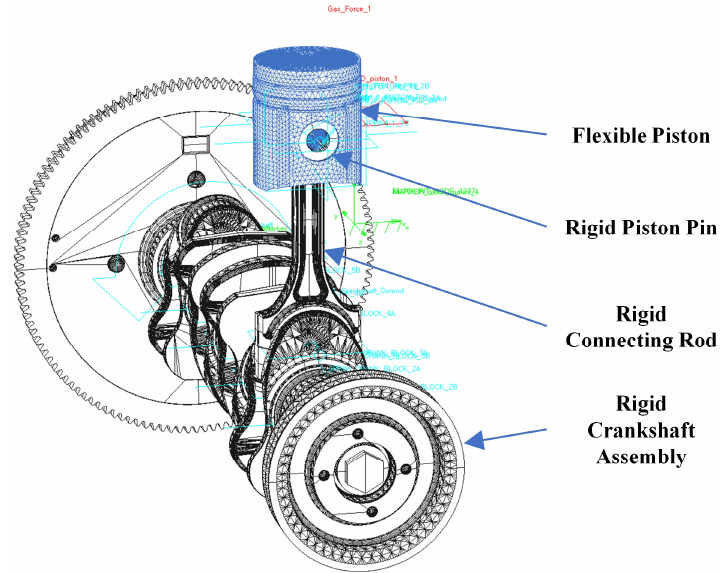
Figure 2. The MBD model of piston–liner interaction. Crankshaft assembly is connected to the engine block via revolute joint with motion applied. Other revolute joints are between the crankshaft asembly-connecting rod and the connecting rod–piston pin. The piston pin is connected to the piston via joint primitives. The gas force is applied at the center of the piston bowl and the modal force is applied on the entire piston flexible body. The engine block is represented as a ground.